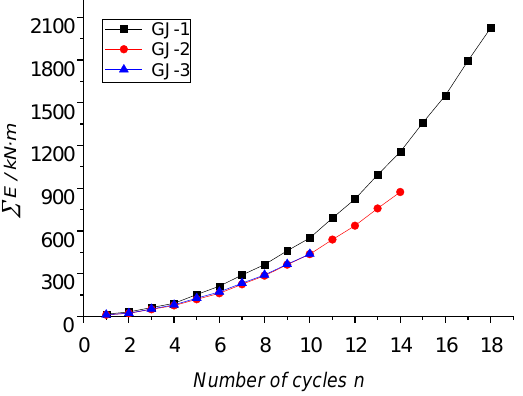
E i , where n is the number of cycles. , where 𝑛 is the number of cycles. i = 1